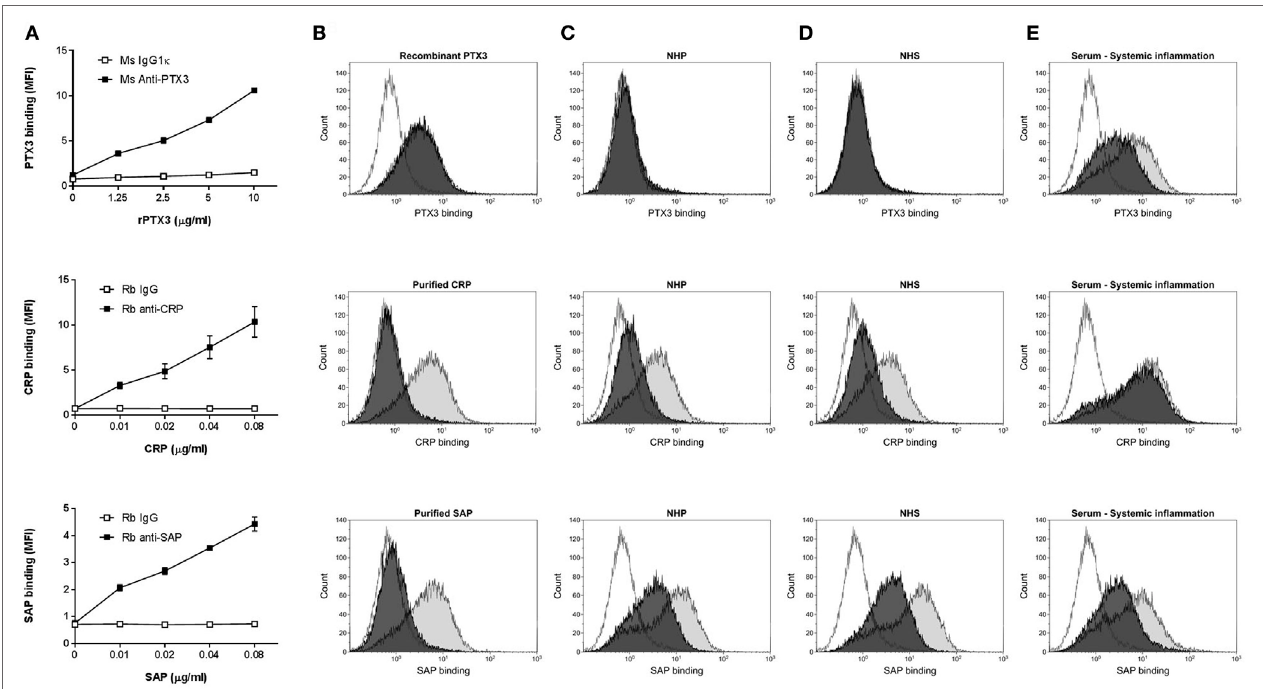
FigUre 1 | Binding of recombinant, purified, and native pentraxin 3 (PTX3), C-reactive protein (CRP), or SAP to CCs. (a) Concentration-dependent binding of recombinant PTX3 (rPTX3), purified CRP (pCRP), and purified SAP (pSAP) to CC. Binding was assessed by flow cytometry as MFI and data are given as mean ± SEM ( n = 3). (B) Binding of rPTX3, pCRP, or pSAP to CC ± 10 mM EDTA (black/gray). (c–e) Binding of native PTX3, CRP, or SAP from 5% NHP (c) , NHS (D) or a pool of serum from three individuals with systemic inflammation (e) diluted in Barbital/BSA ± 10 mM EDTA (black/gray). Isotype controls are shown as white histograms. Histograms represent one of three independent experiments. CCs, cholesterol crystals; NHP, normal human plasma; NHS, normal human serum; MFI, median fluorescence